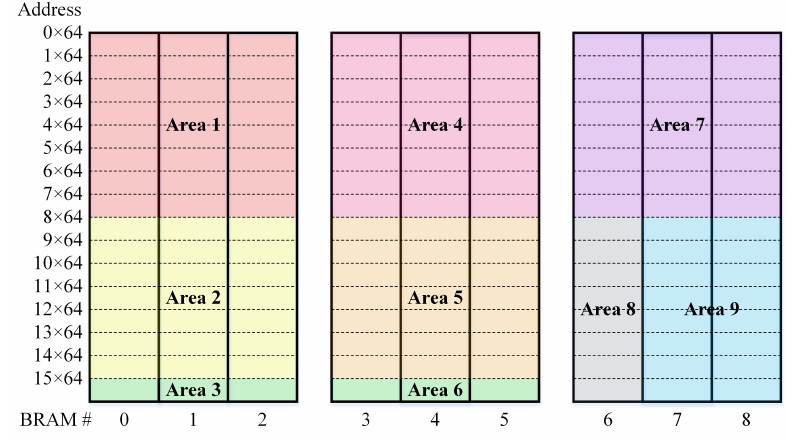
Figure 6: Structural arrangement of the BRAM